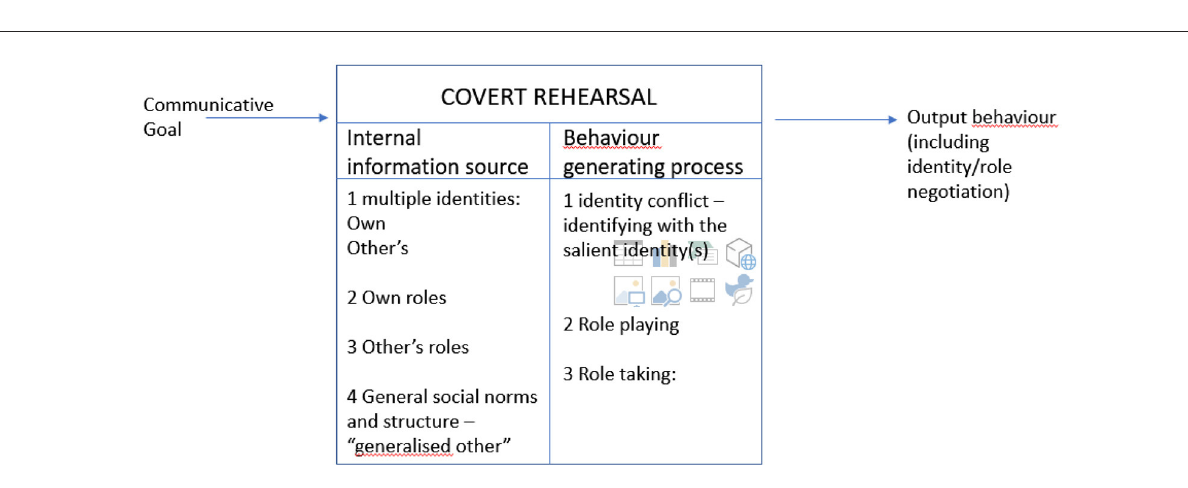
FIGURE2 Intrapersonal level of covert rehearsal (revised based on Hulett,